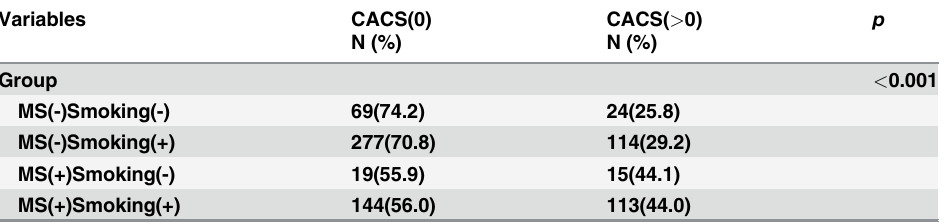
Table 4. Association between Metabolic Syndrome and/or Smoking Status and Coronary Artery